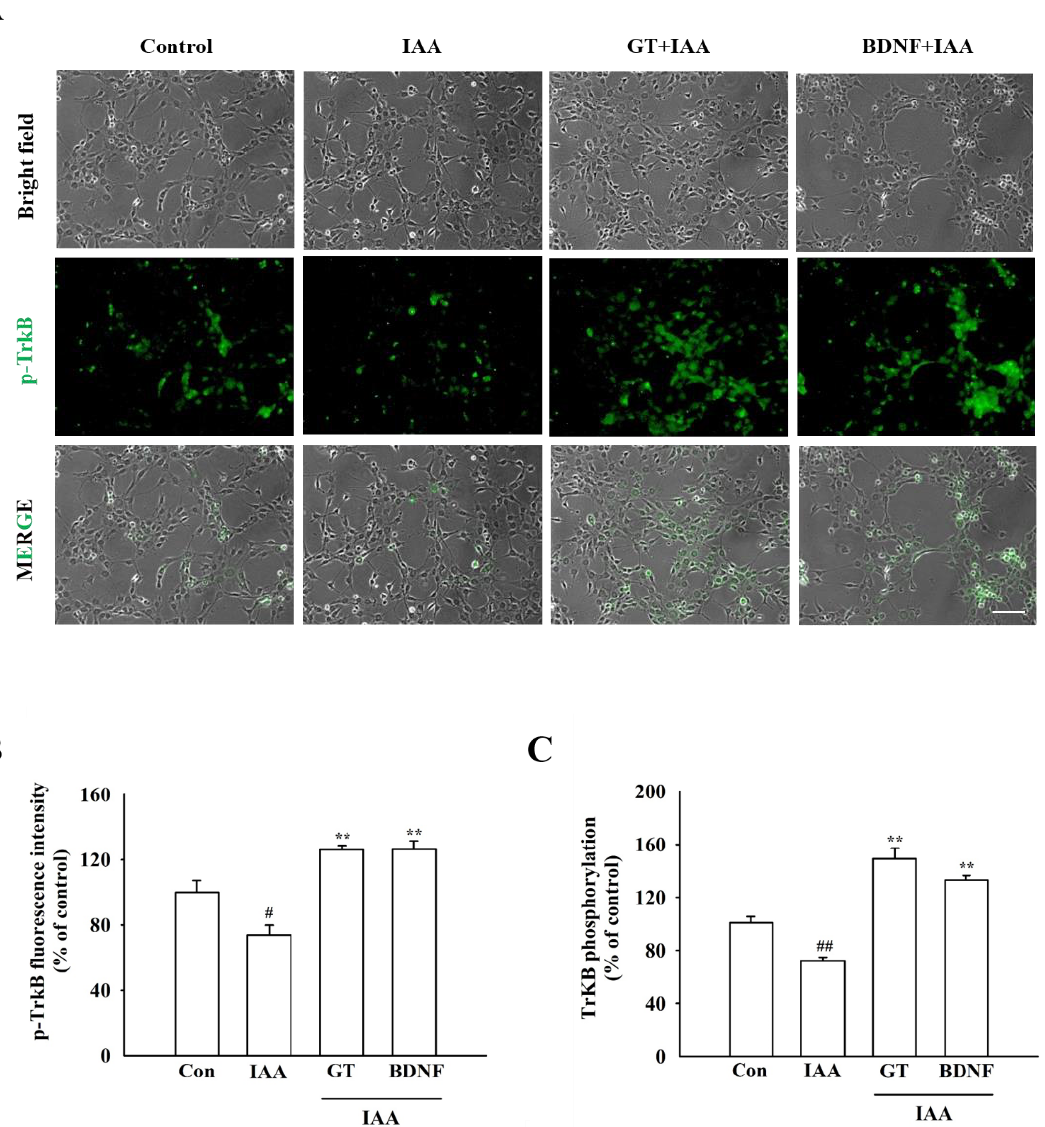
Figure 5. Effect of gintonin on the activation of TrkB receptors in IAA-treated HT22 cells. ( A ) Representative microscopy images of TrkB phosphorylation. HT22 cells were exposed to IAA (5 μM, 2 h) and treated with gintonin (3 μg/mL, 24 h) or BDNF (30 ng/mL, 24 h). Phosphorylated TrkB is dyed green. Microscopy images were captured at the same magnification, scale bar = 100 µ m. ( B ) Quantitative analysis of the images obtained from fluorescence microscopy. ( C ) The level of phosphorylation of TrkB receptors measured using a phosphor-TrkB ELISA kit. The data are expressed as the mean ± standard error of the mean (SEM; n = 4). # p < 0.05 and ## p < 0.01 compared to the control group; ** p < 0.01 compared to the IAA-treated